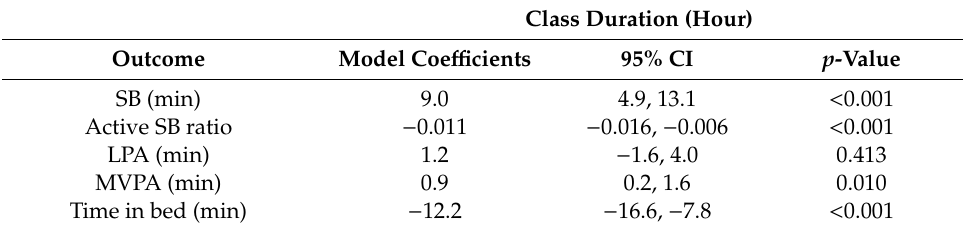
Table 3. Association between class duration and students’ activity levels. A.